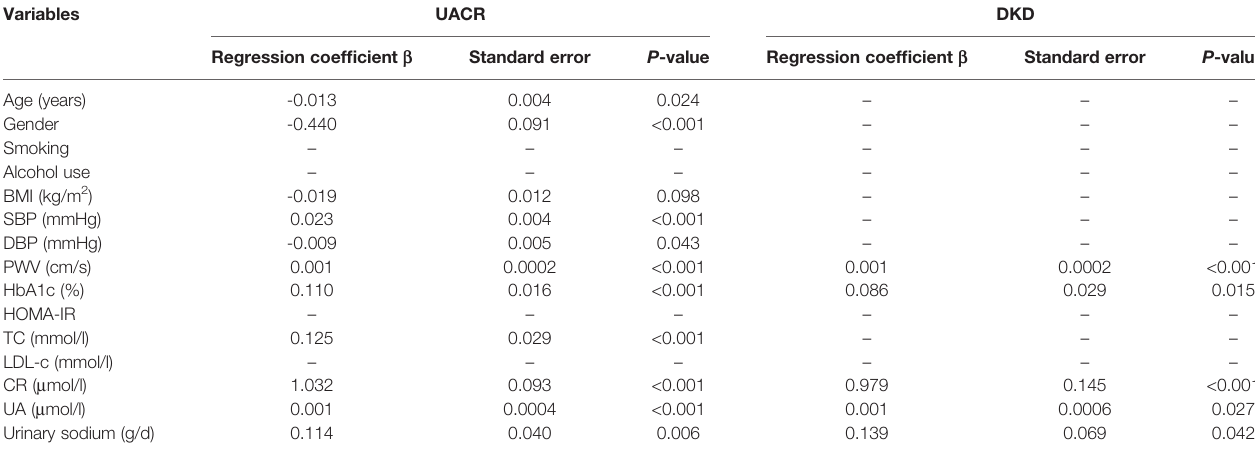
TABLE 3 | Stepwise regression analysis with UACR level and